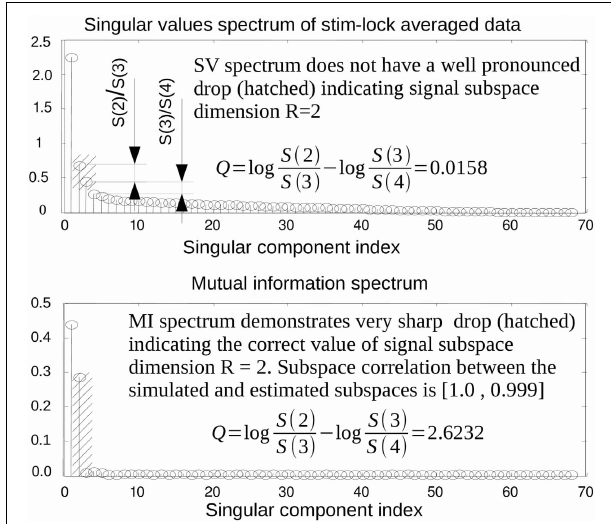
FIGURE 1 | In some practical cases, the first singular topographies remain reasonably good estimators of signal subspace but inspection of the SV spectrum fails to reveal this as illustrated by a model example here. While the subspace spanned by the first two singular topographies and the actual simulated subspace practically coincide the SV spectrum ( top panel) fails to reveal the fact that the second singular component also belongs to the signal subspace. On the contrary the MI spectrum ( bottom panel) computed using raw data projected onto the left singular vectors demonstrates a very clearly cut separation of the task-related and task unrelated subspaces. This figure also introduces the measure of task-related subspace identifiability used in the paper. Since the correct signal subspace rank value is R = 2, we use discriminating indicator (cid:3) (cid:2) (cid:3) (cid:2) S ( 2 ) S ( 3 ) − log that formalizes the strategy employed by the q = log S ( 3 ) S ( 4 ) human observers and estimates the amount of drop between the second and the third components referenced to the ratio of the two largest components of the noise range spectrum (with indices 3 and 4) immediately following the two signal components (with indices 1 and